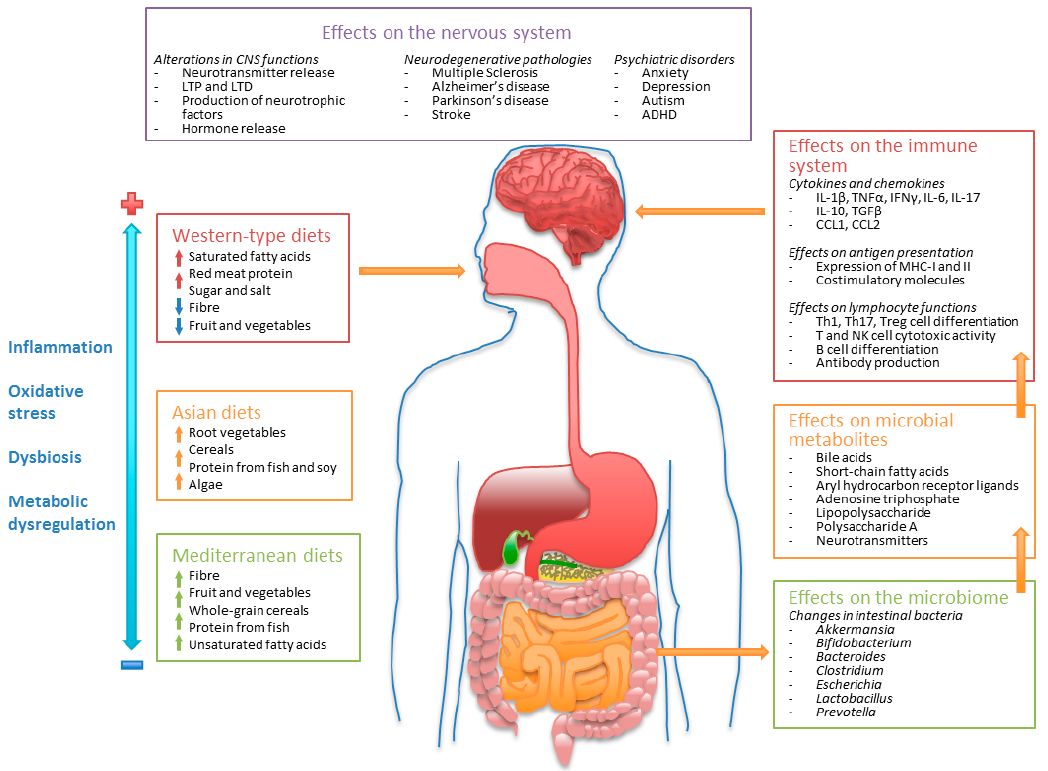
Figure 1. Dietary patterns and modulation of the intestinal microbiome, immune, and nervous systems. Dietary patterns promote changes in the intestinal microbiome, a ff ecting the production of bacterial metabolites that, in turn, modulate immune and nervous system functions, either increasing or decreasing the susceptibility for neurologic and psychiatric disorders. Western-style diets are related to increased inflammation, oxidative stress, dysbiosis, and metabolic abnormalities, whereas traditional Mediterranean and Asian diets are considered beneficial for human health [24–31]. CNS: